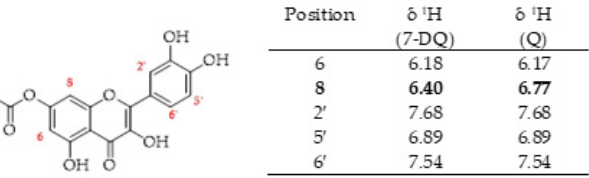
Figure 1. Chemical shifts of the quercetin moiety of 7-docosahexanoylquercetin (7-DQ) and quercetin